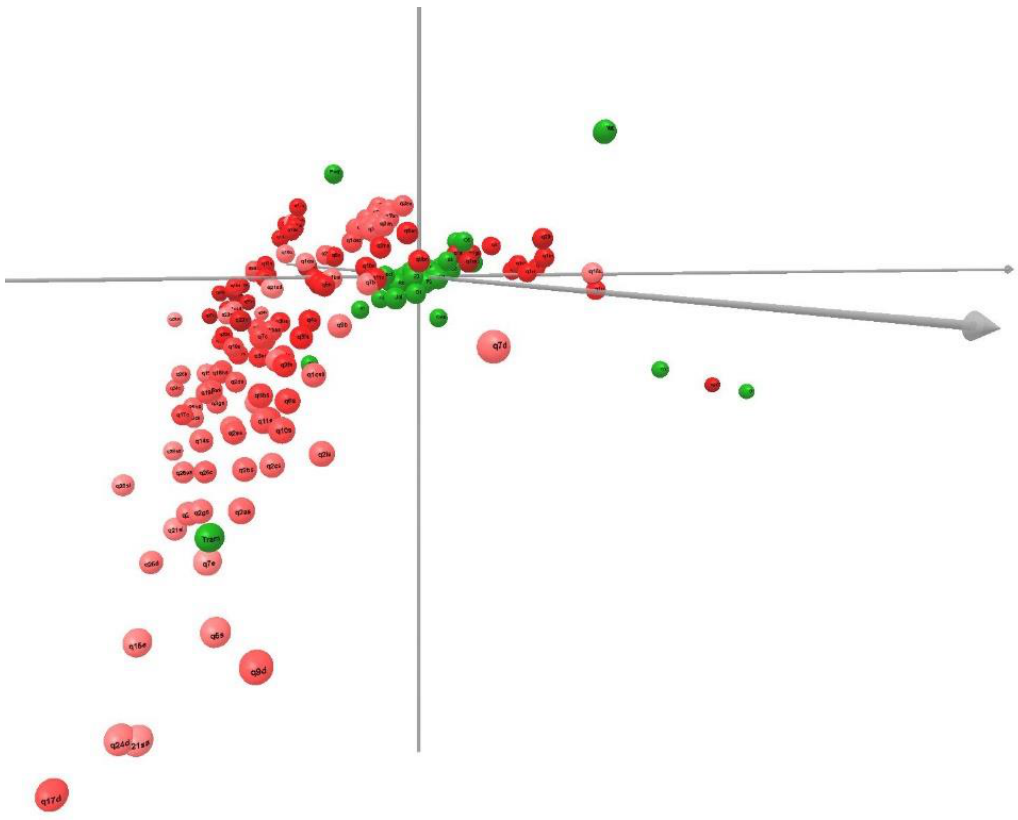
Figure 4. Relationship of all the variable categories with respect to the 3 dimensions (Please see: https://youtu.be/_MX7RO3TlfQ). Abbreviations: Please see Table 3 and Table A1—Appendix A.